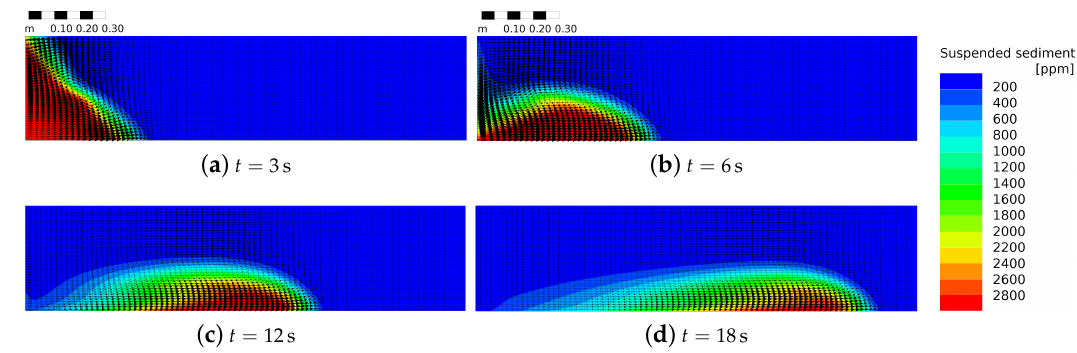
Figure 3. Formation of the turbidity current after release of the sediment suspension into clear water in the lock-exchange experiment (case A, longitudinal section [19]); flow direction from left to right, concentration contours in